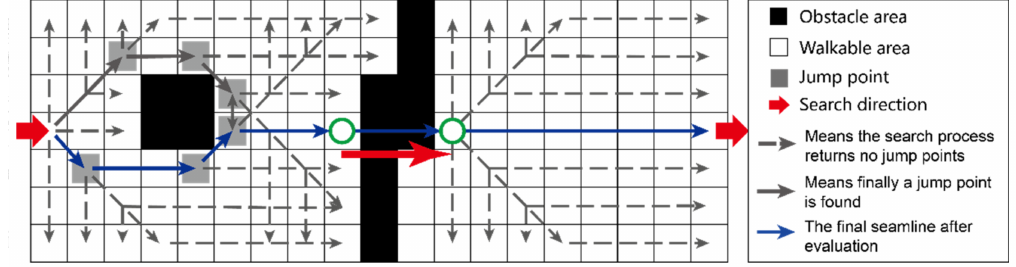
Figure 9. An illustration of forcing the seamline to cross an obstacle. Select the node with the lowest h ( n ) in the close list, then cross the obstacle forcibly from the left green circle to the right green